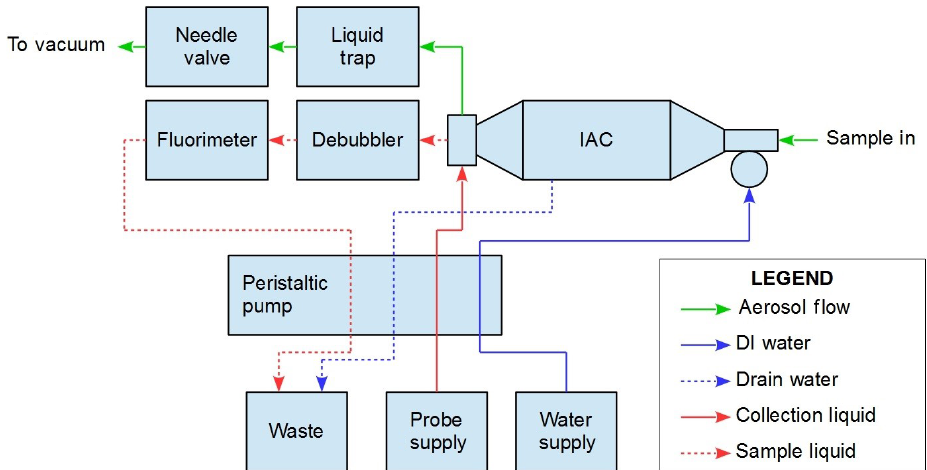
Figure 1. Diagram of the PINQ system showing all major components and the aerosol and liquid flow paths linking them.